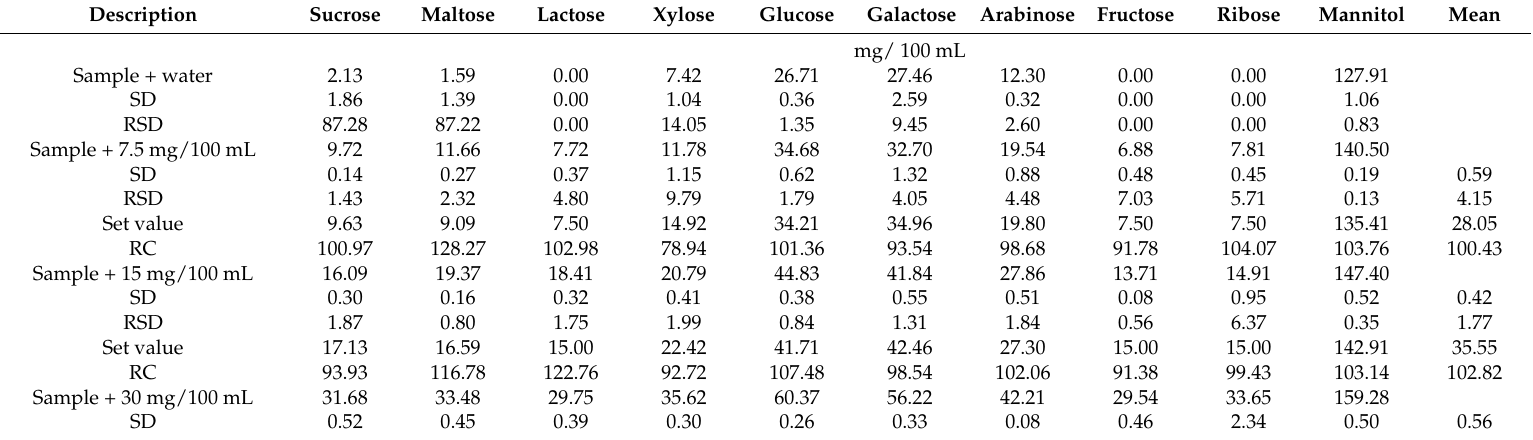
Table 6. Recovery rate (RC, %), absolute (SD) and relative (RSD, %) standard deviation in an aqueous maize silage extract ( n = 3) spiking with authentic